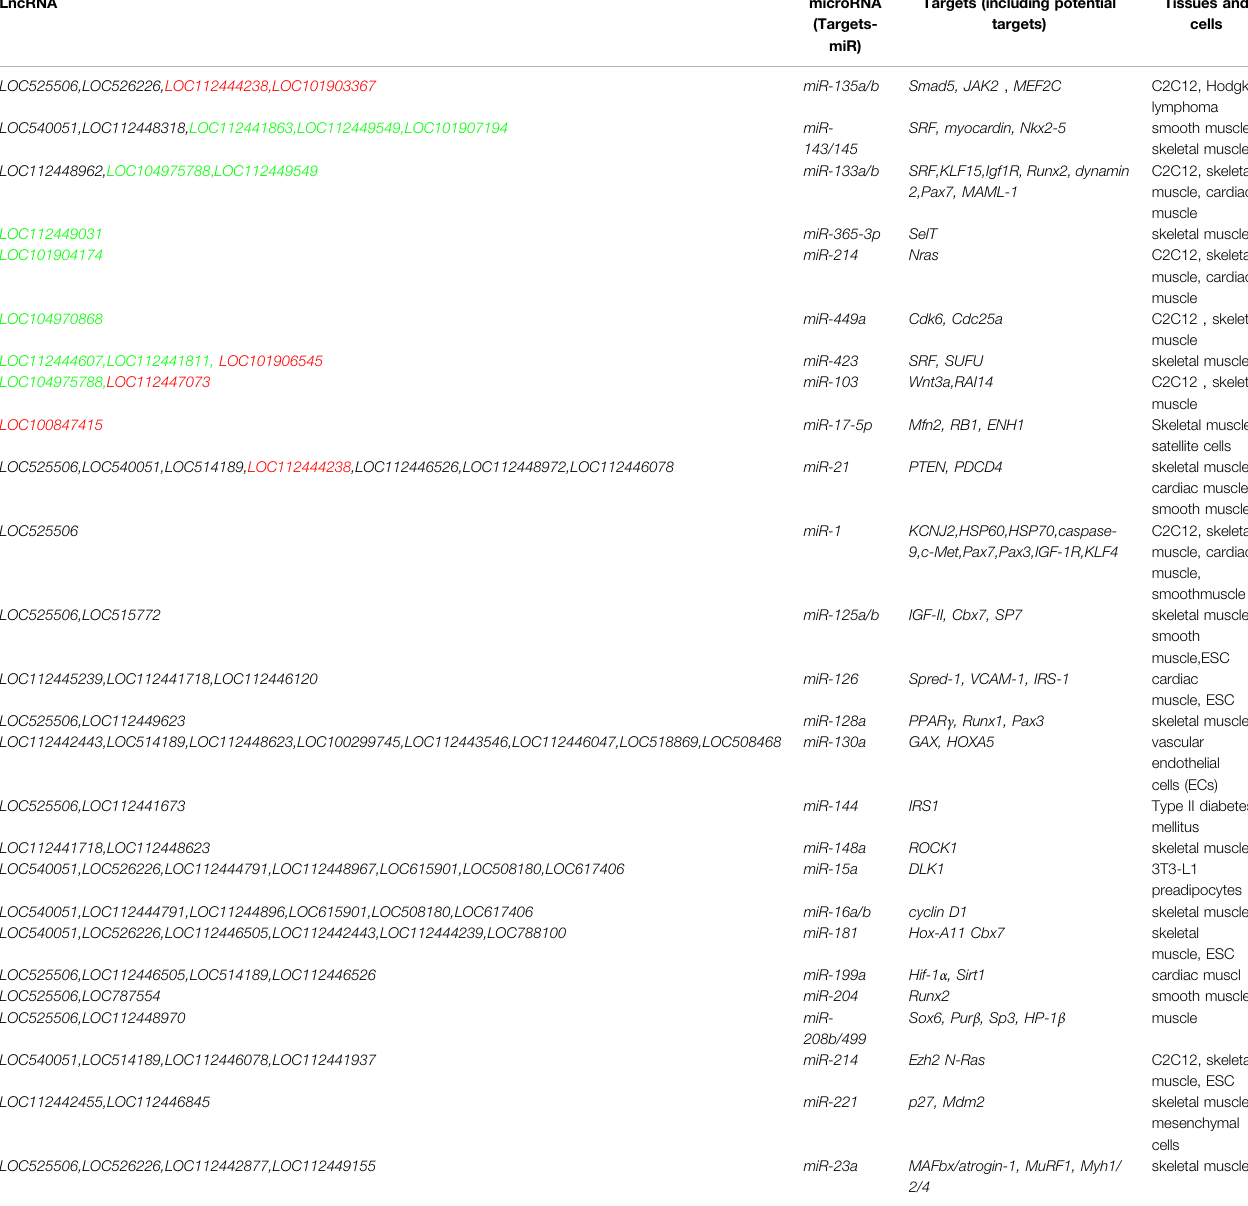
Note: Green represents up-regulated LncRNAs, red represents down-regulated LncRNAs, black represents LncRNAs, with no signi fi cant difference.